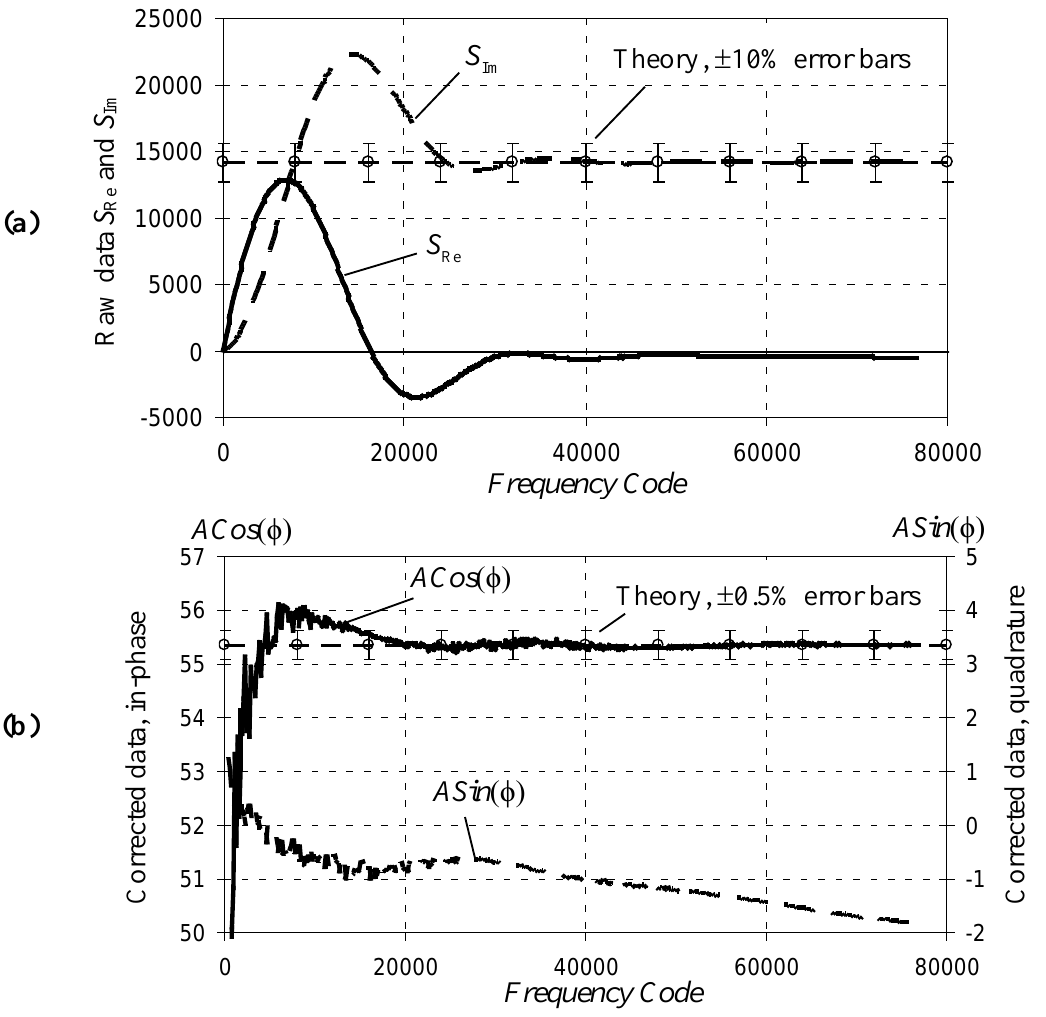
Figure 10. Raw data for 140 kΩ resistor as DUT: ( a ): raw data S Re and S Im and ( b ): data processed according to Equations (3) left y -axis for and right y -axis for